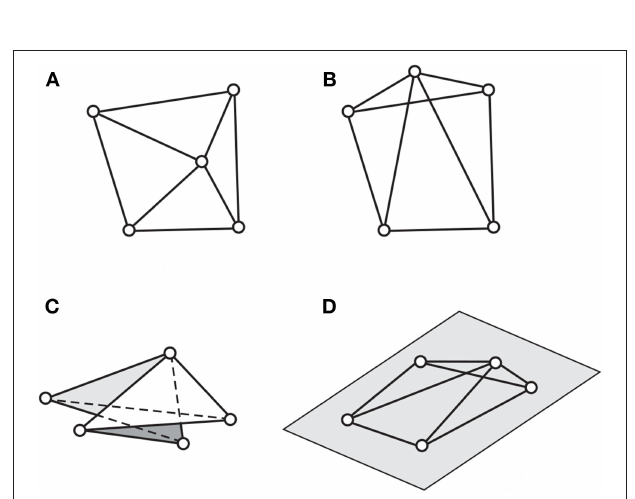
FIGURE 6 | Globally rigid (A) and universally rigid (B) frameworks. When these are considered in three dimensions, the framework (A) can flex out of plane, as in (C) , the one in (B) can only stay in a plane (D) .